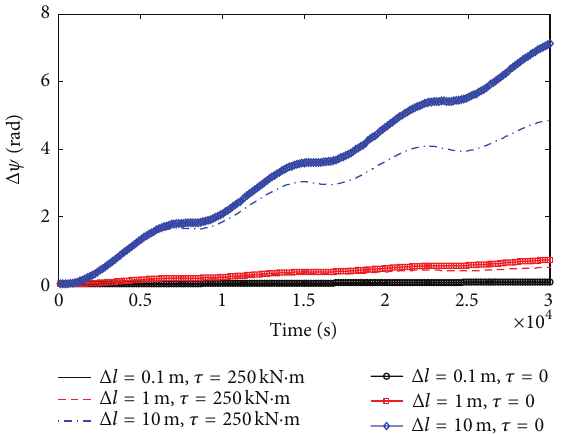
Figure 14: Time history of Δ𝜓 with different Δ𝑙 .